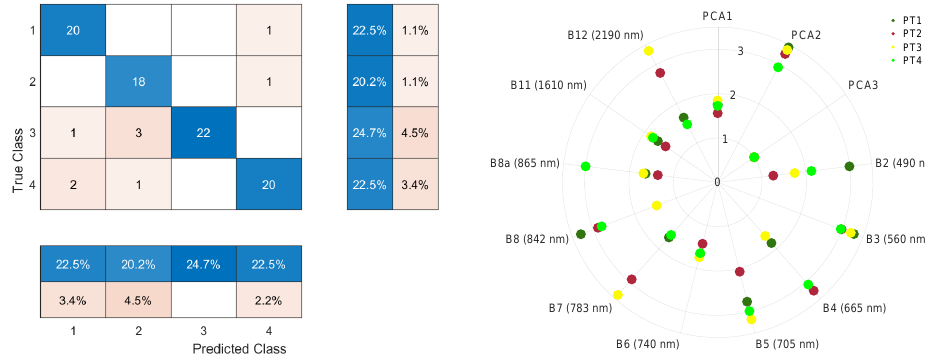
Figure 5. Left : confusion matrix of GPC against validation data with correct detection in the blue shade and wrong detection in the red shade. Furthermore, summary percentages per class are provided. Right : polar plot of GPC band relevance for the four classes calculated according to the equations described in [74]. The further away from center, the more